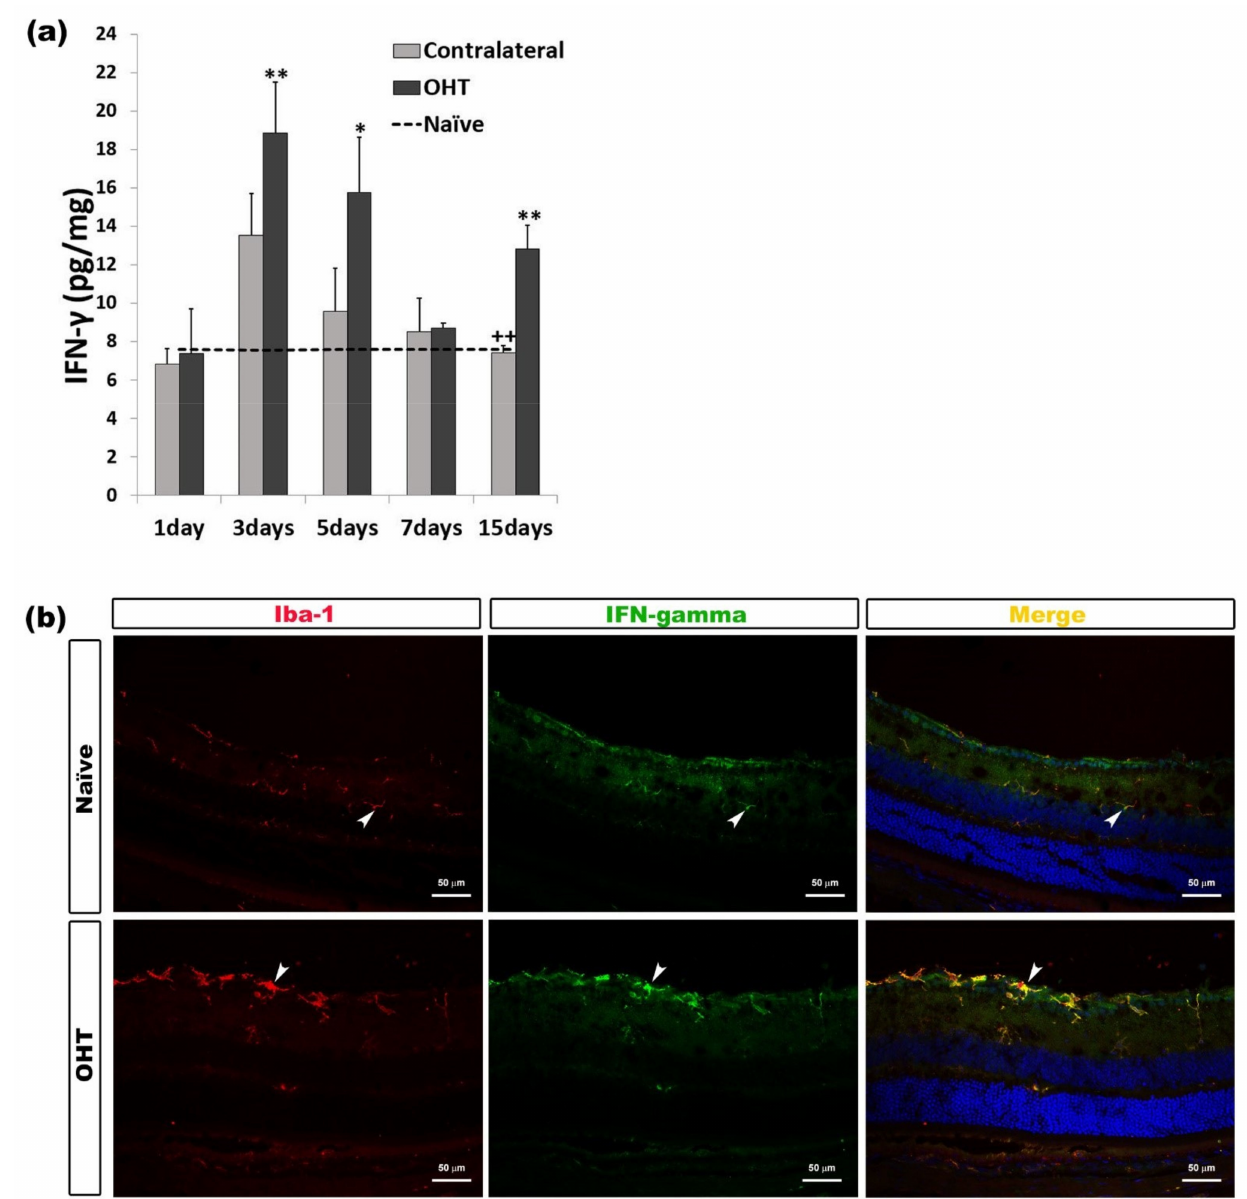
Figure 4. IFN- γ levels at different times after laser-induced ocular hypertension (OHT). ( a ) The variation over time in the IFN- γ levels in the multiplex assay. The histogram shows the mean levels ( ± standard deviation, SD) of IFN- γ (pg/mg) at days 1, 3, 5, 7, and 15 after laser OHT induction, in ocular hypertension eyes (OHT) and in contralateral eyes. The dashed line indicates the mean levels in naïve eyes. Statistical significance indicators: * p < 0.05, ** p < 0.01 vs. naïve; ++ p < 0.01 vs. OHT. ( b ) Immunohistochemical study of IFN- γ expression in OHT eyes three days after unilateral laser-induced OHT. Retinal sections were immunolabeled with antibodies to IFN- γ (green) and Iba-1 (red). Merge (yellow). The arrowheads indicate the co-expression of Iba-1 and IFN- γ in both naïve and OHT eyes. The expression is more intense in OHT eyes. Abbreviations: OHT (ocular hypertension); IFN- γ (interferon-gamma); Iba-1 (ionized calcium-binding adaptor molecule